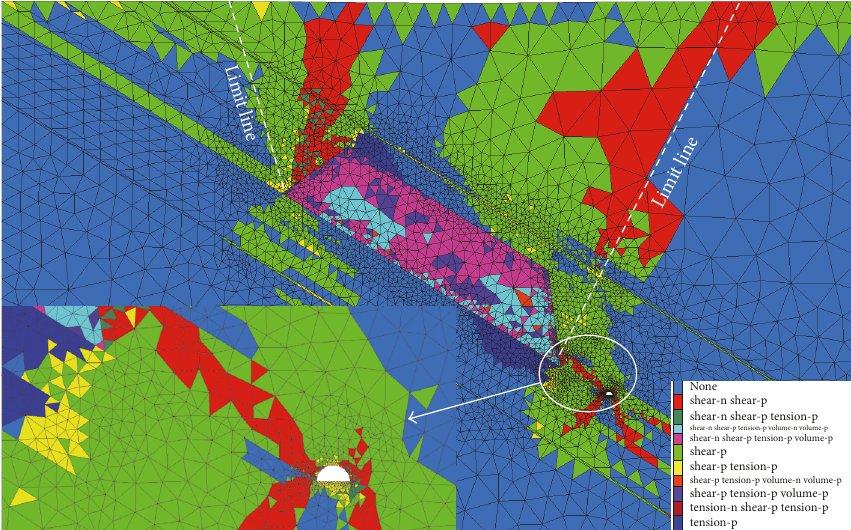
Figure 15: Yield elements after extraction of 1409 panel.